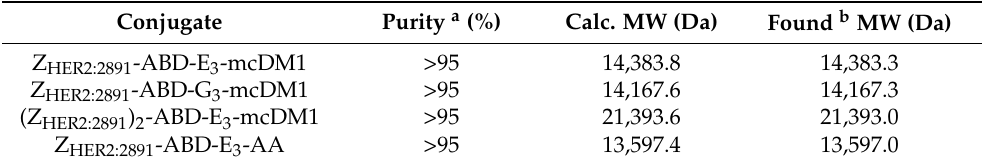
Table 1. Biochemical characterization of the AffiDCs.